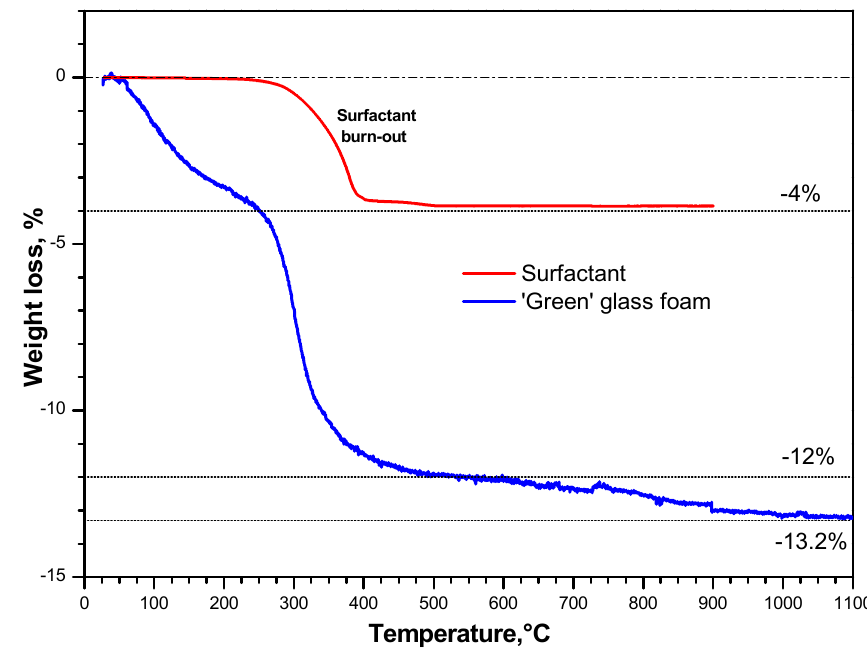
Figure 4. Thermo-gravimetric plot of alkali-activated W-D glass and surfactant.